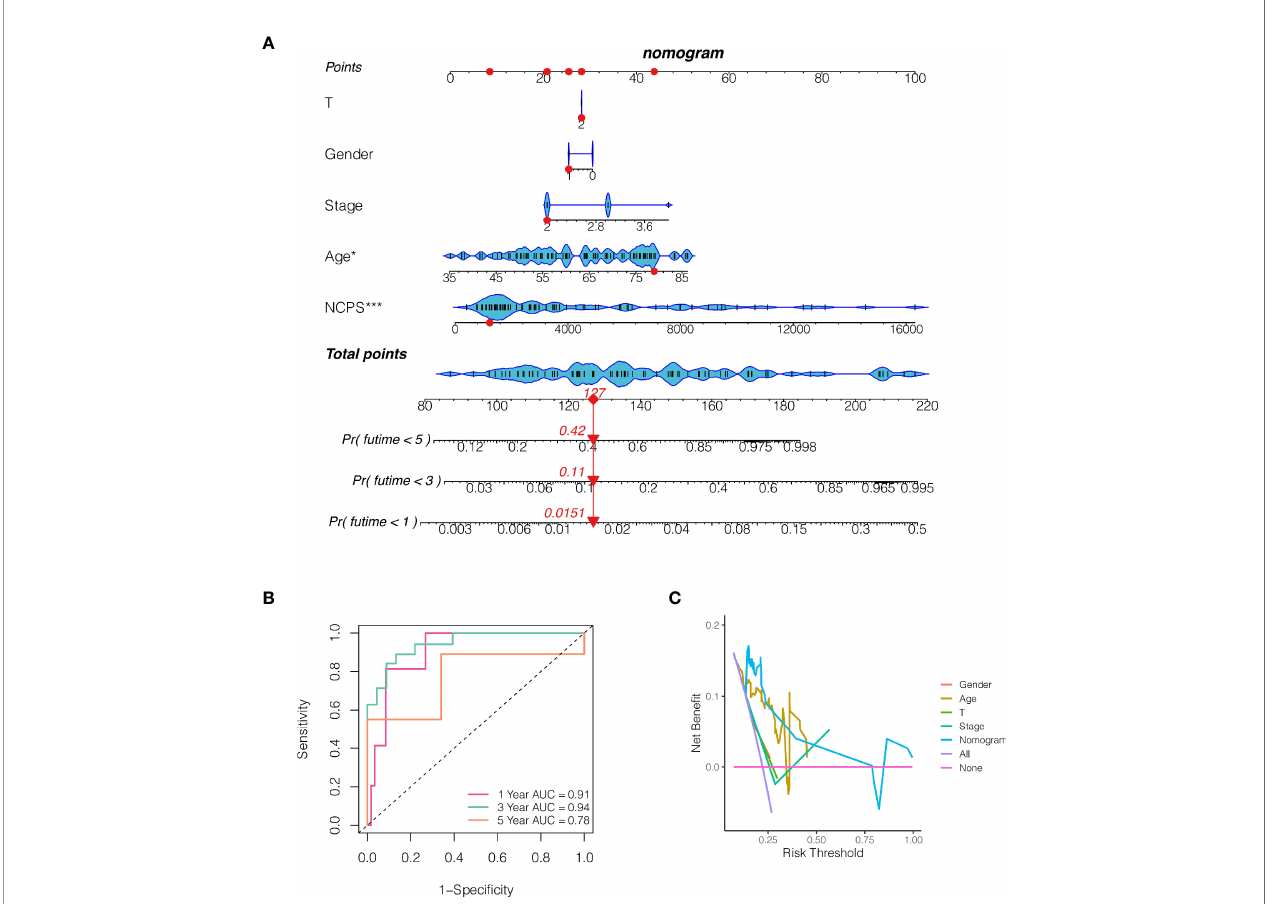
FIGURE 6 | The construction of a nomogram. (A) Nomogram of patient “ TCGA-VD-AA8R ” . The mortality rate of the patient in 1, 3 and 5 years was estimated to be 0.015, 0.11 and 0.42. (B) ROC curve of the nomogram. The area under the curve (AUC) in 1, 3 and 5 years were 0.91, 0.94 and 0.78 respectively. (C) Decision curve analysis. The effect of this nomogram was superior to other clinical